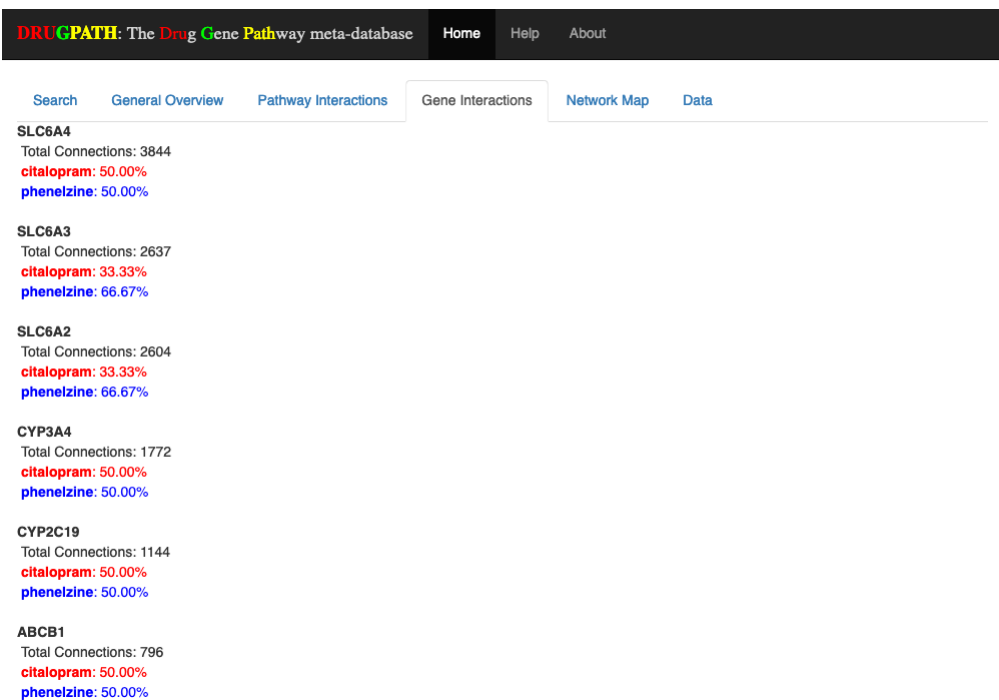
Figure 3. Genes interactions between citalopram and phenelzine. Note that only the first few results are